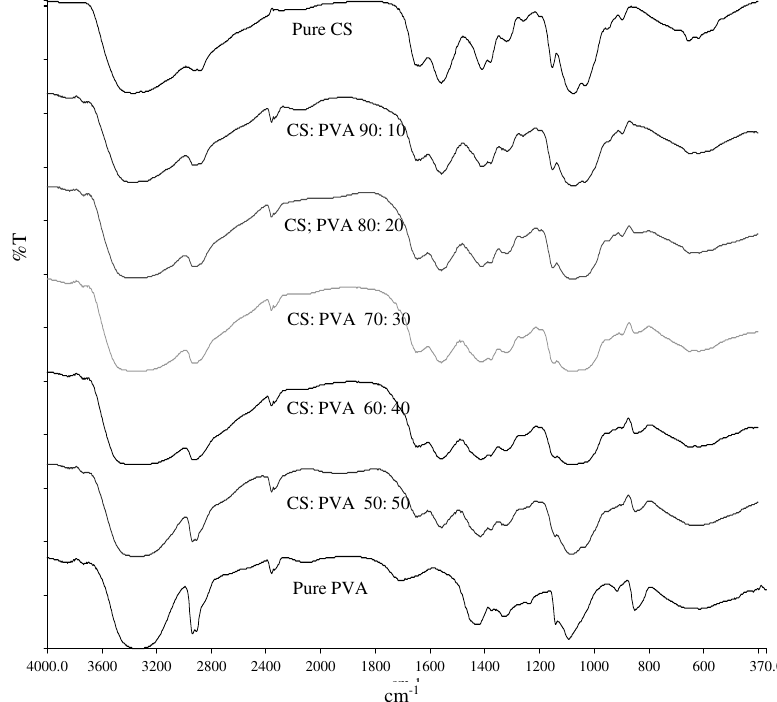
Figure 1. Typical FTIR spectra of pure chitosan, pure PVA and their blended films having various proportions Table 1. FTIR characteristic bands of chitosan/PVA blend films CS/PVA, % C-C